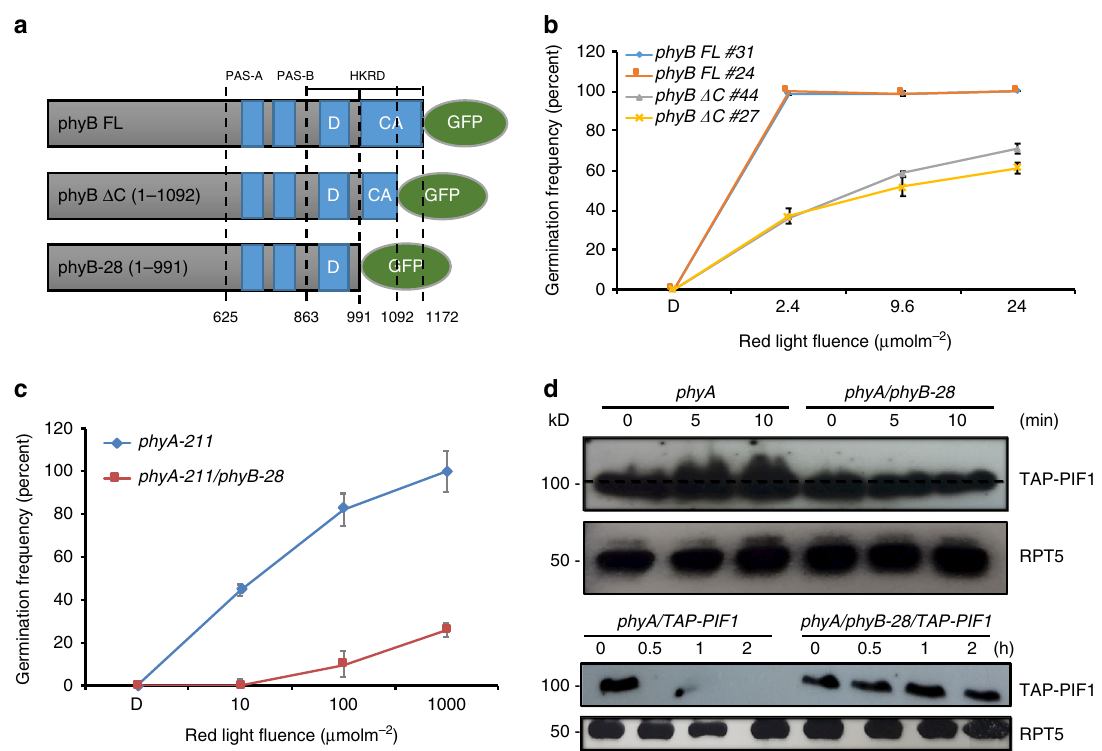
Fig. 7 Direct interaction between phyB and SPA1 is necessary for phyB-mediated seed germination. a Schematic diagram of phyB-28, phyB-GFP Δ C and phyB-GFP FL proteins. b , c The C-terminal SPA1-interaction domain of phyB is necessary for phyB-mediated seed germination. phyB-GFP Δ C displays reduced germination compared to phyB-GFP FL lines, while phyB-28 displays slower germination compared to wild type ( phyA-211 that contains wild type PHYB ). The error bars indicate s.e.m. ( n = 3). d The light-induced phosphorylation and degradation of TAP-PIF1 is defective in phyB-28 compared to wild type ( phyA-211 that contains wild type PHYB ). Total protein was extracted from four-day-old dark-grown seedlings either kept in darkness or exposed to continuous red light (3.5 μ molm − 2 s − 1 ) over